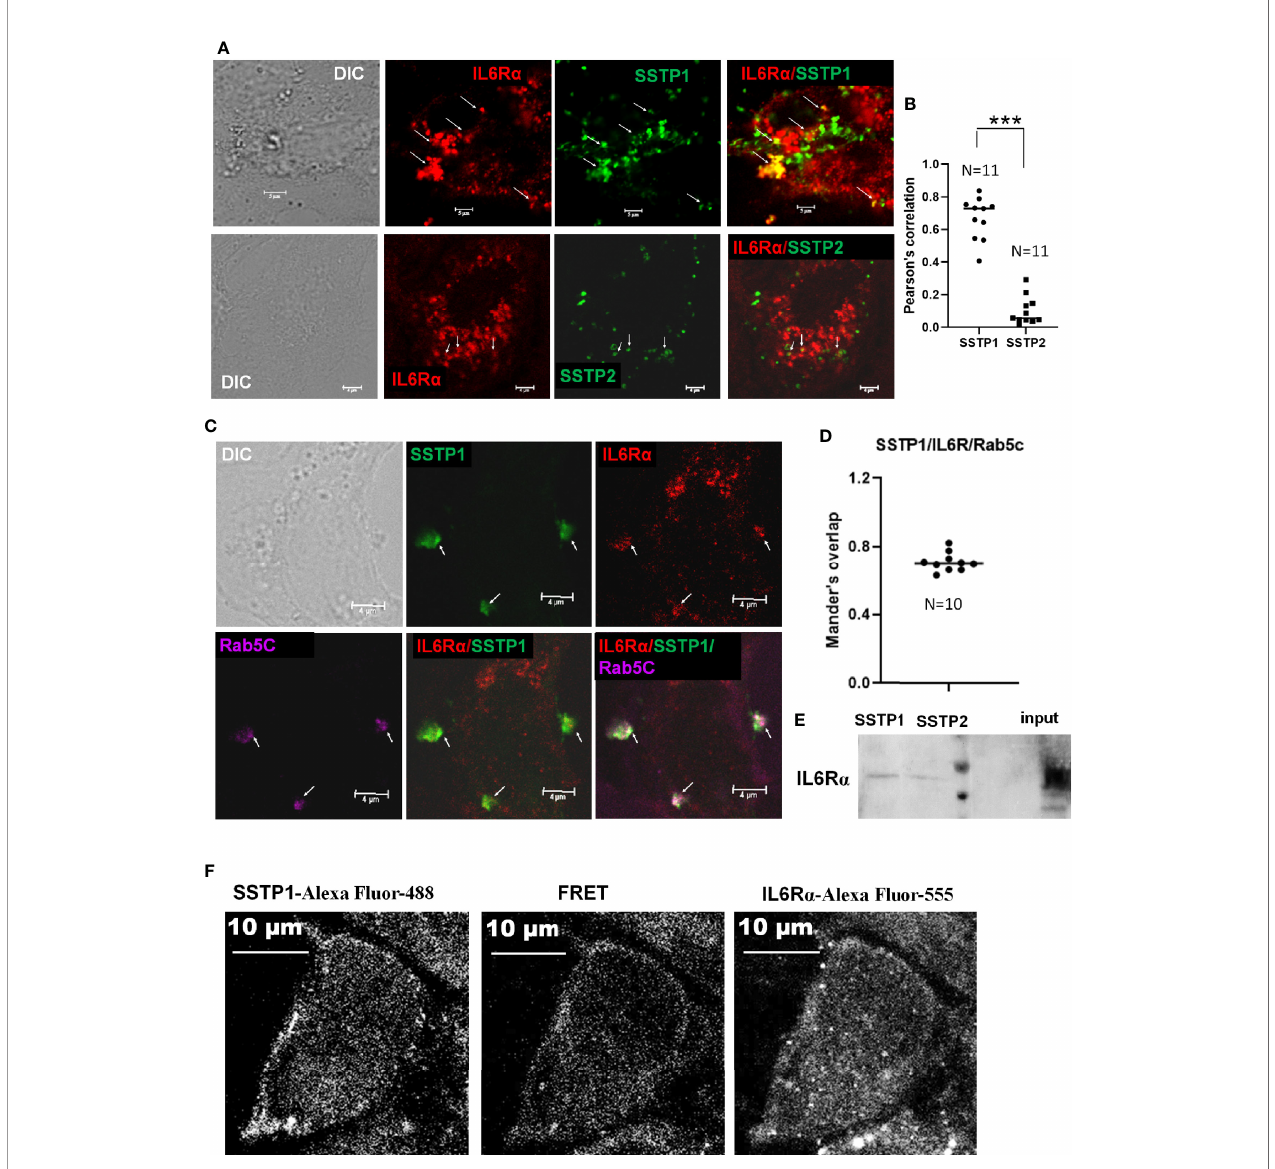
FIGURE 5 | SSTP1 interacts with IL6R a and mediate the uptake of SSTP1 (A) HSC-4 cells were treated with Biotin labeled-SSTP1 or SSTP2 (10 m M) for 30 minutes and then fi xed and probed without permeabilization using mouse IL6R a (2B2.3). (B) The co-localization of SSTP1 or SSTP2 to IL6R a was analyzed for 11 cells, and the Pearson ’ s correlation was plotted. (C) Cells were treated as in panel A and fi xed and permeabilized to probe for IL6R a , SSTP1 and Rab5C. The arrow mark indicates co-localization. The scale bars represent 4 m m (D) The Mander ’ s overlap in SSTP1 foci were quanti fi ed for 10 cells. The average value for each cell is plotted (E) Pull-down assay using SSTP1-biotin or SSTP2-biotin and probed for IL6R a . (F) FRET analysis to show the SSTP1 binding to IL6R a as described in Methods. The scale bars represent 10 m m for panel (A, F) . ***p <